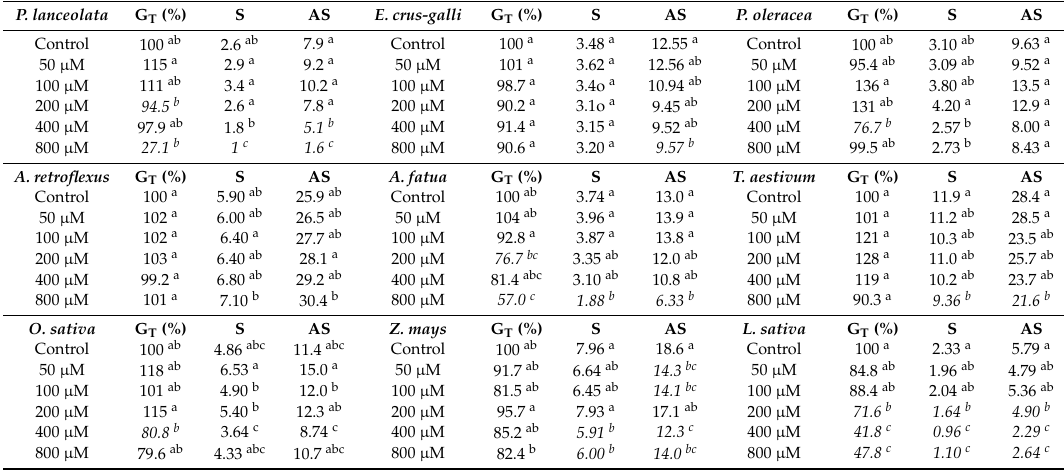
Table 1. Values of G T (total germination rate, expressed as percentage with respect to the control), S (average speed of germination) and AS (speed of accumulated germination) obtained by crop and weed species in germination assays after treatment with NOR concentrations (0–800 µ